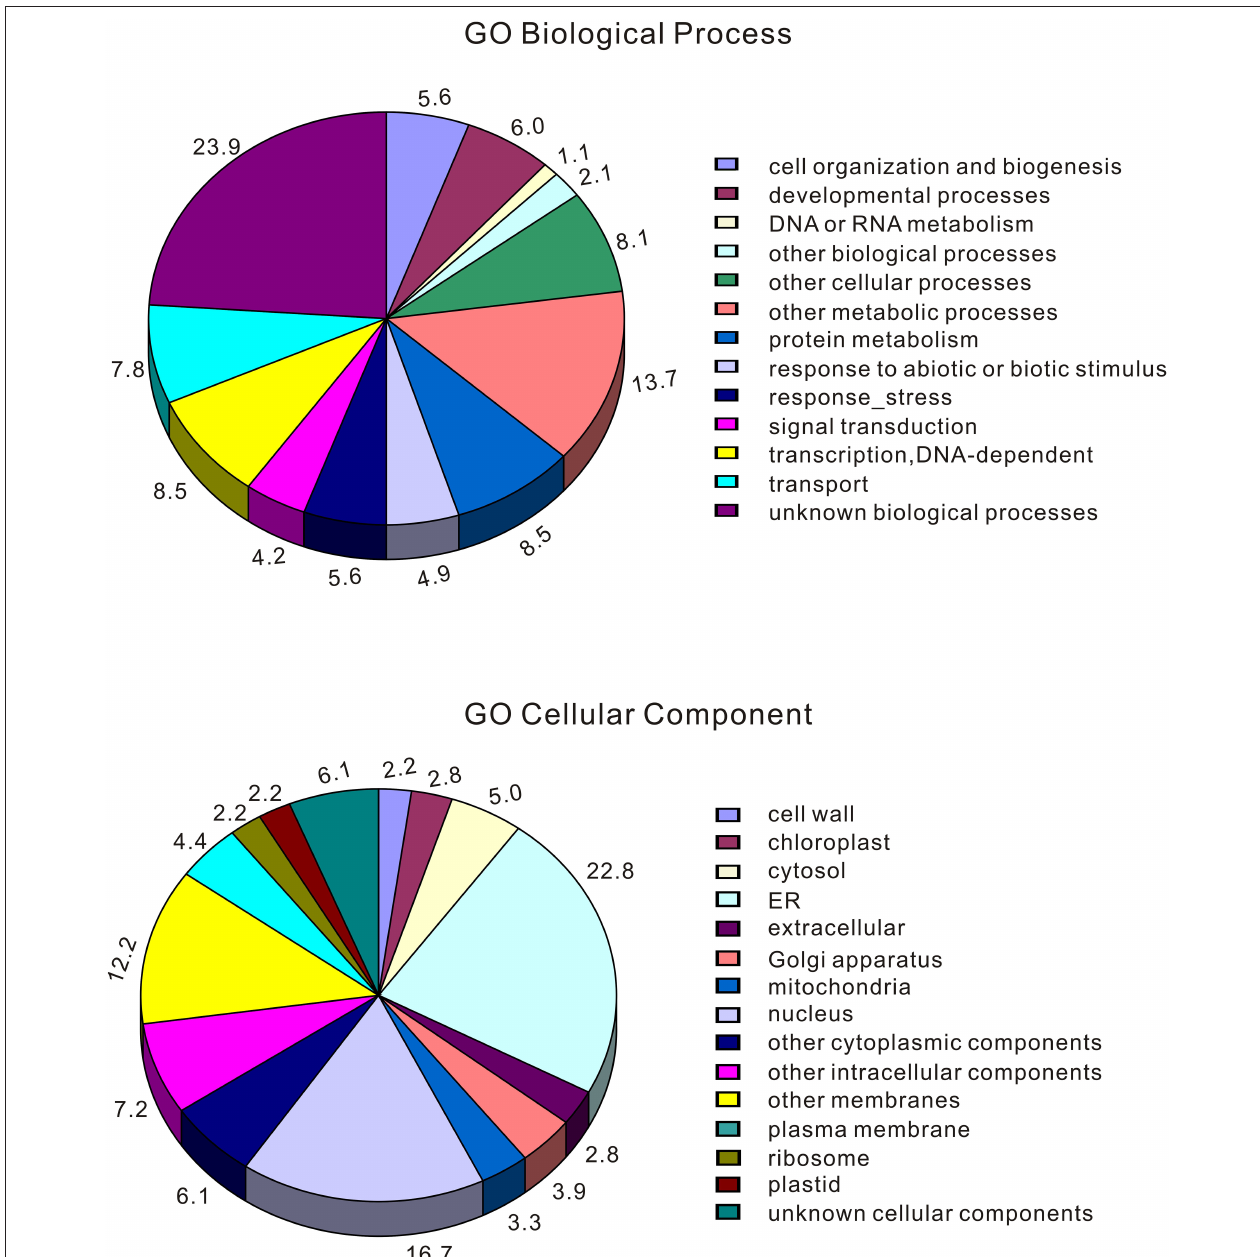
FIGURE 2 | Categorization of those genes located at selected windows by Gene Ontology (the entire data). Eutrema salsugineum genes were assigned an A. thaliana locus and then categorized using TAIR automatic system. Note that a gene may be assigned to more than one biological process in the GO classification